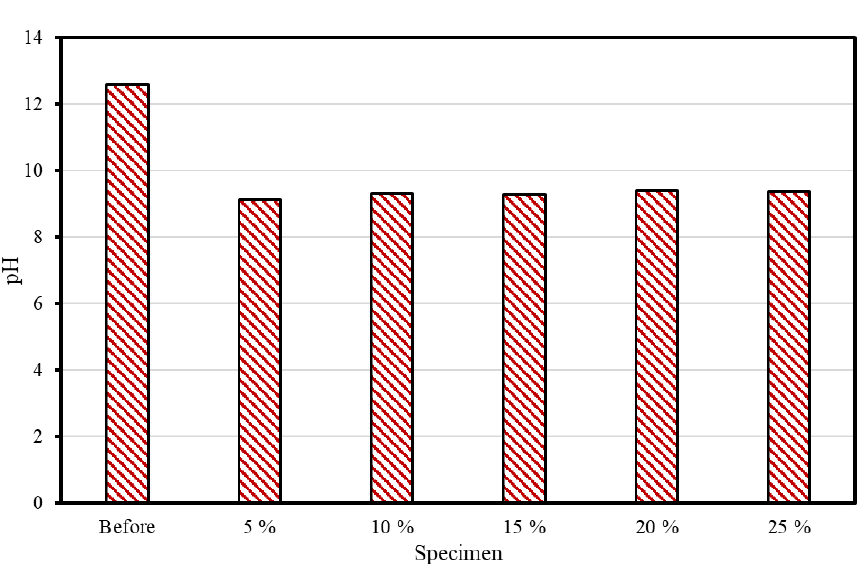
Figure 5. pH measurement outcomes.